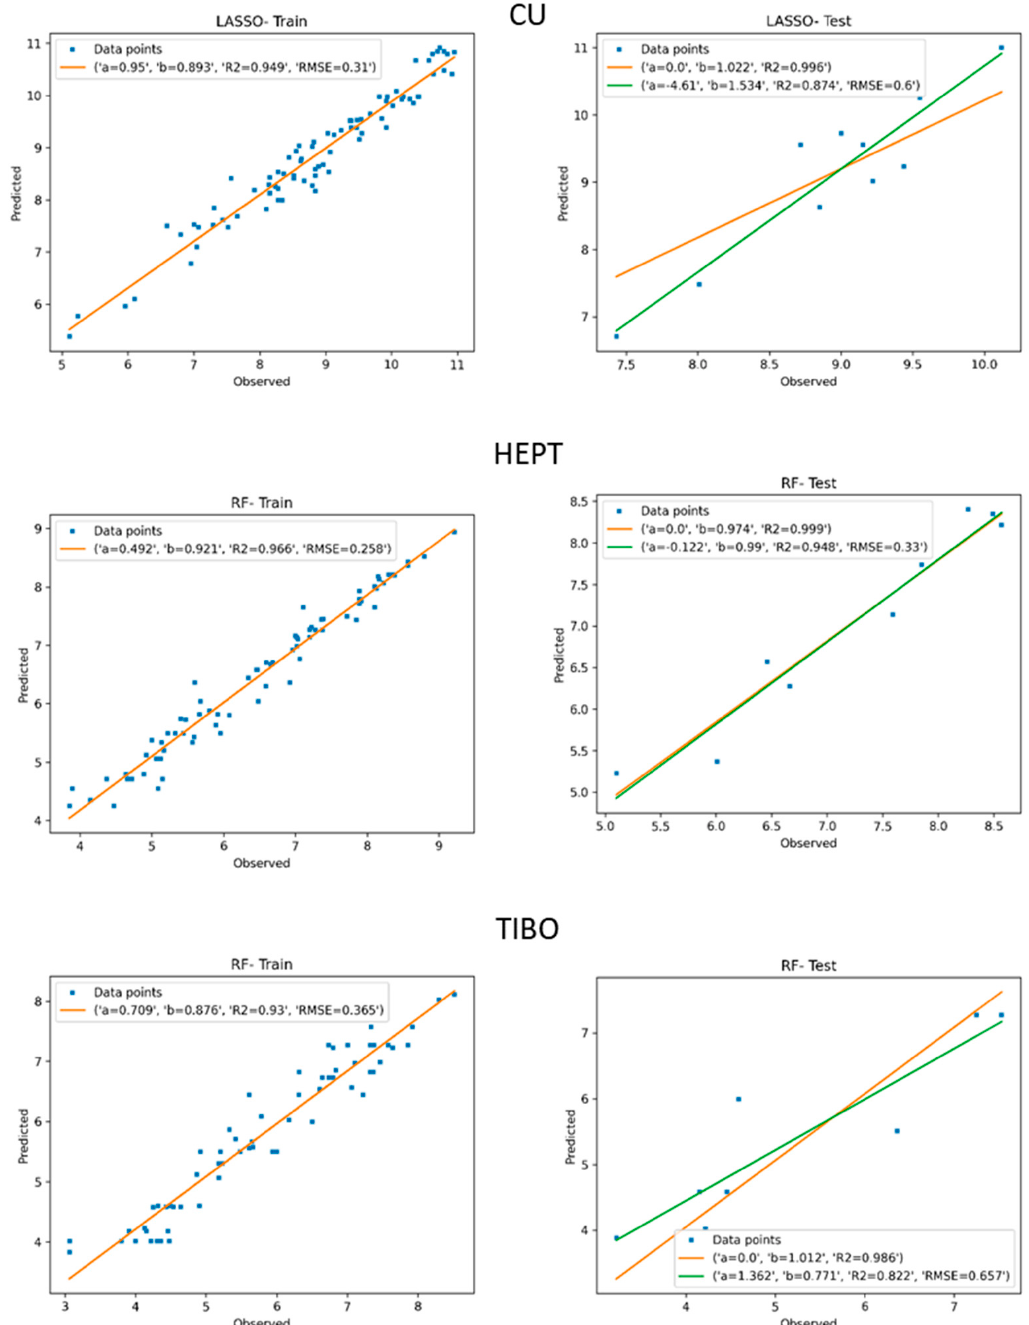
Figure 11. QSAR for the anti-HIV activity: observed vs. predicted anti-HIV activity (log(1/IC 50 )) for the training (upper right) and test set (upper left) of: cyclic urea (CU) derivatives using the LASSO model, for the training (center right) and test set (center left) of HEPT derivatives using the RF model, for the training (down right) and test set (down left) of TIBO derivatives using the LASSO model.